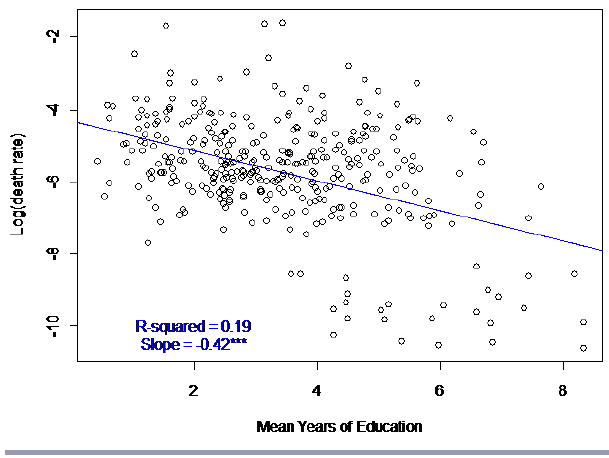
Fig. 4 . Log of death rate by mean years of schooling of population aged 15 to 39 at the community